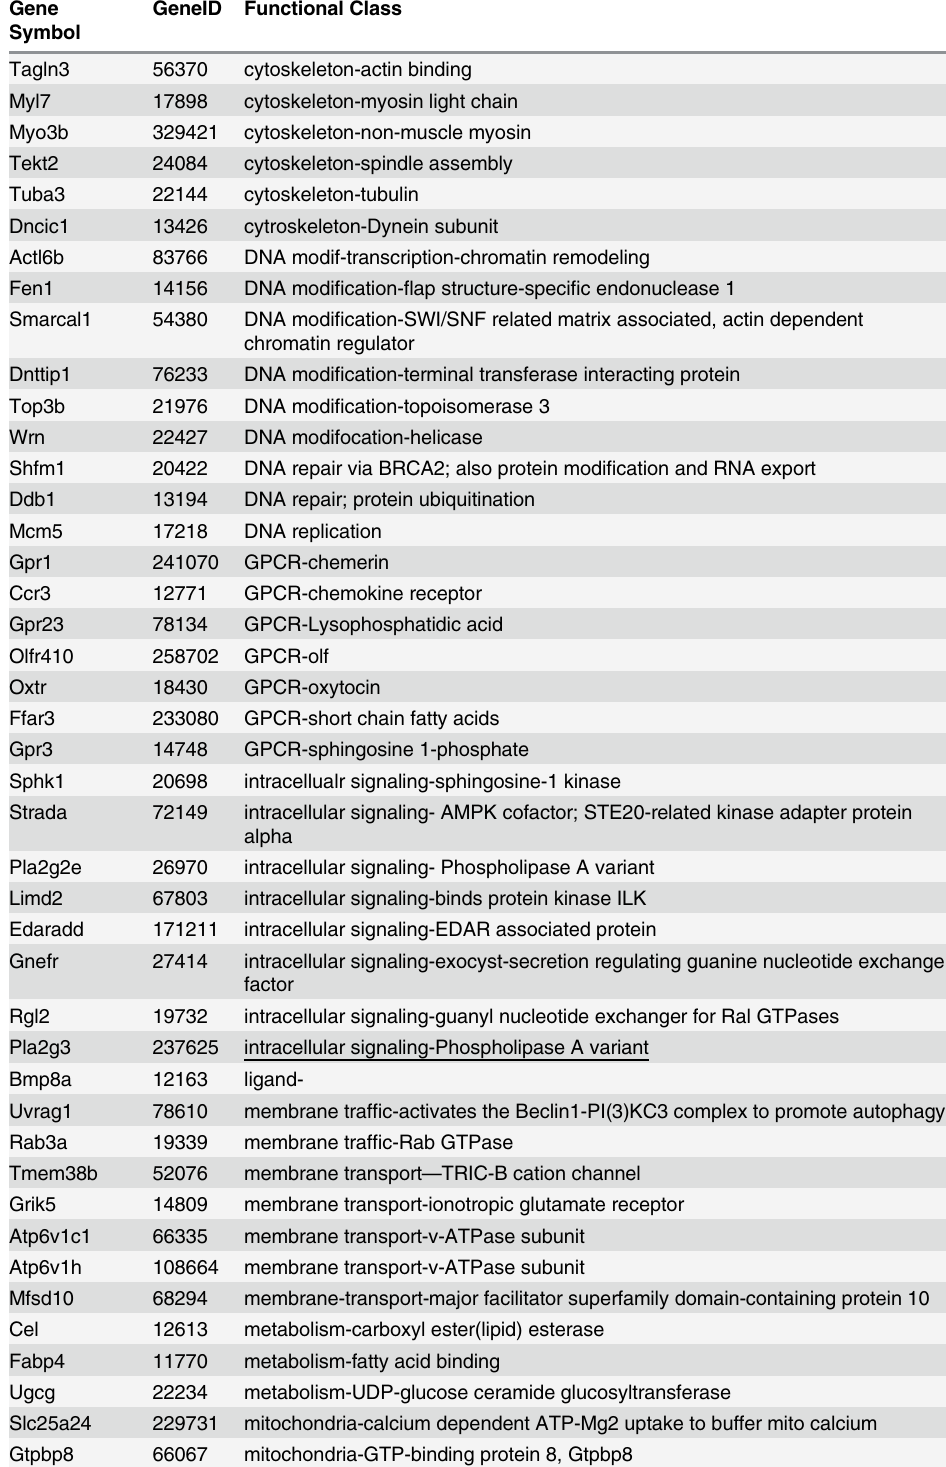
Table 1. Genes in Tsc1 null MEFs scoring positive in 2 or more